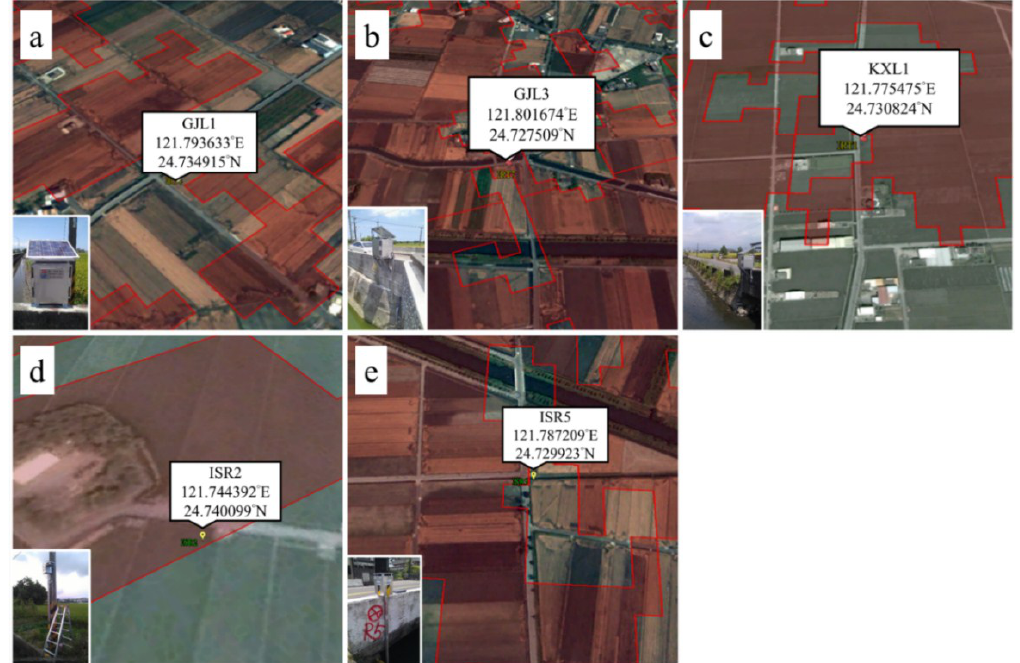
Figure 10. The close-up photo of water level gauge and the inundated areas (red shaded polygons) interpreted from the SAR imagery of five stations: ( a ) GJL1, ( b ) GJL3, ( c ) KXL1, ( d )ISR2, ( e ) ISR5, the name and location of each station is defined and illustrated in Figure 3 that were not consist with the interpretation results. These five stations are all located in a mixed pixel near the boundary of the inundated area.